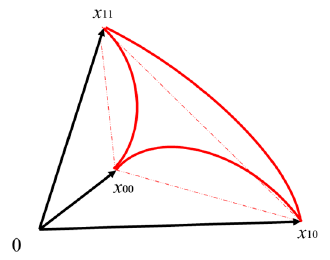
Figure 5. Vertex one-to-one correspondence.